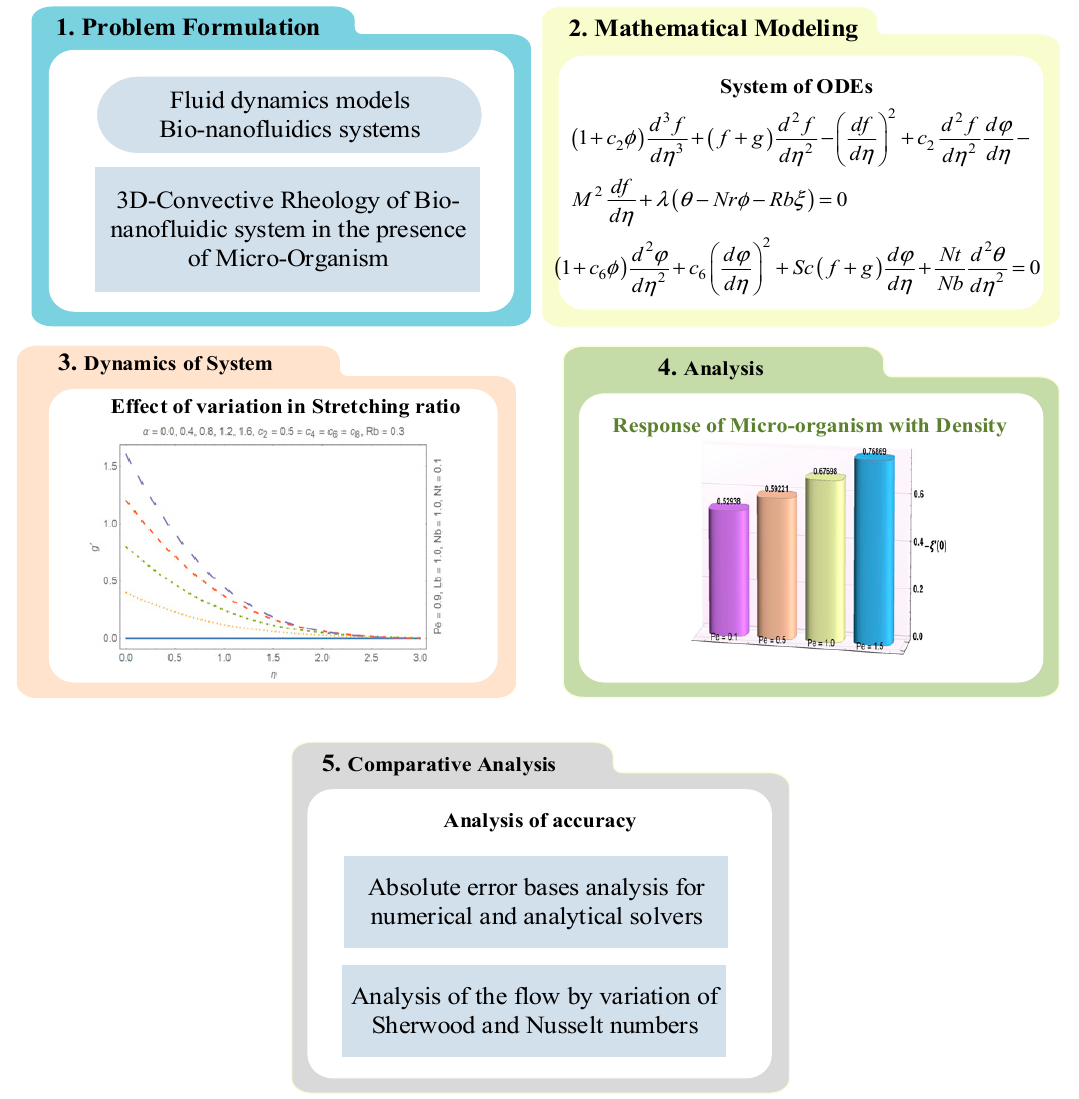
Figure 1. Block structure representation of workflow of the system.